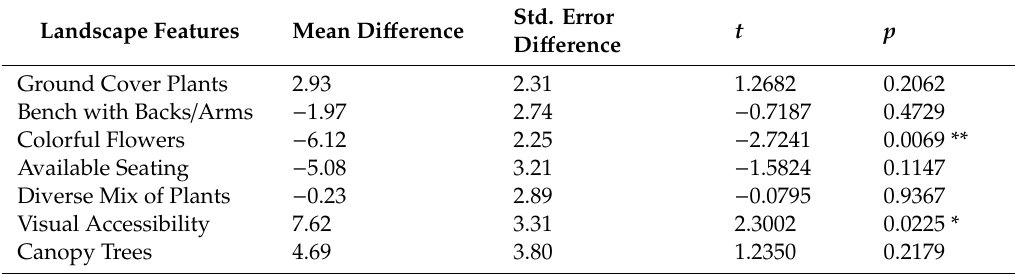
Table 4. Gender di ff erences in preference for hypothesized Table 4. Gender differences in preference for hypothesized features. Table 4. Gender differences in preference for hypothesized features.